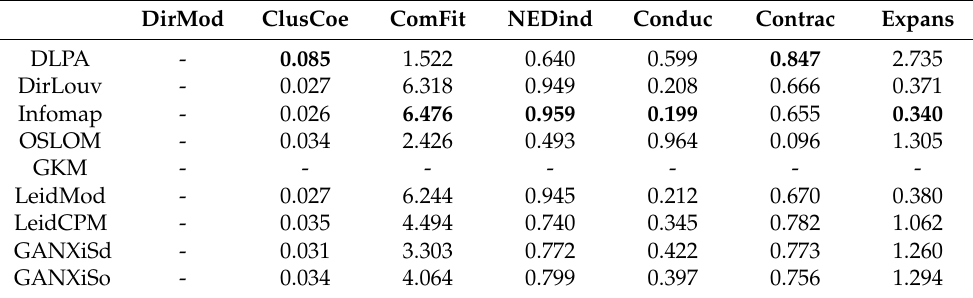
Table 5. Results of evaluations by metrics on the Ferguson dataset.